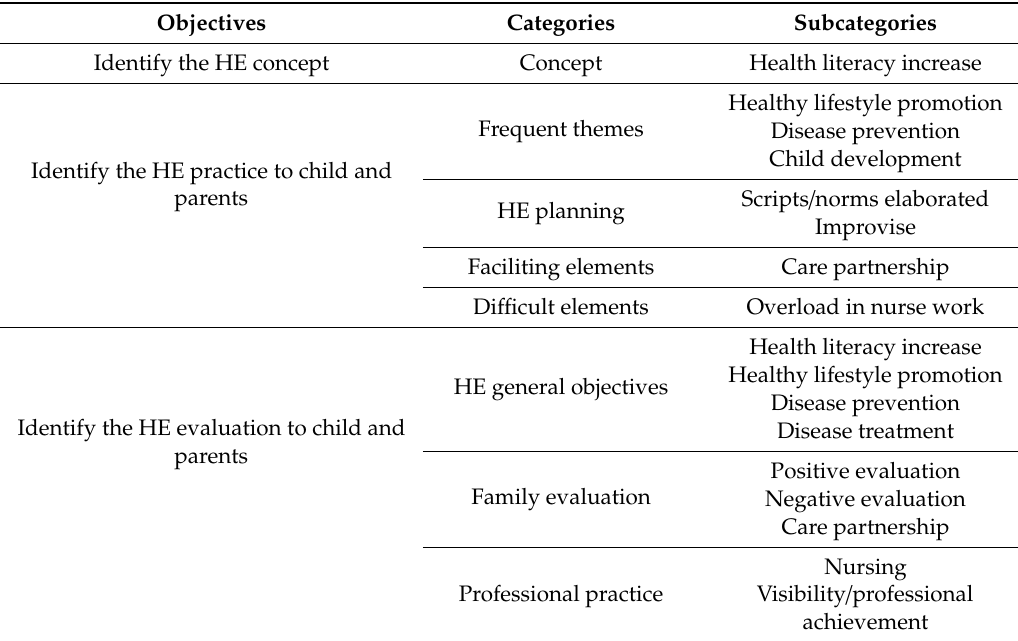
Table 2. Presentation of the objectives, categories, and subcategories resulting from the parents’ interviews, Tr á s-os-Montes and Alto Douro, northern Portugal, Portugal, 2017 ( N =